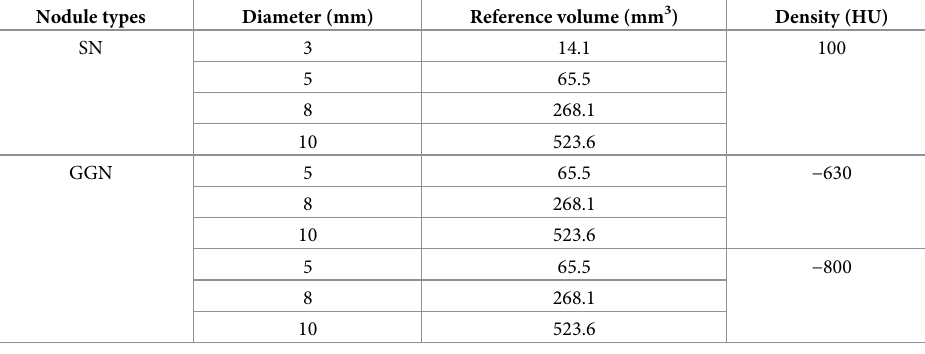
Table 1. Characteristics of ten spherical synthetic